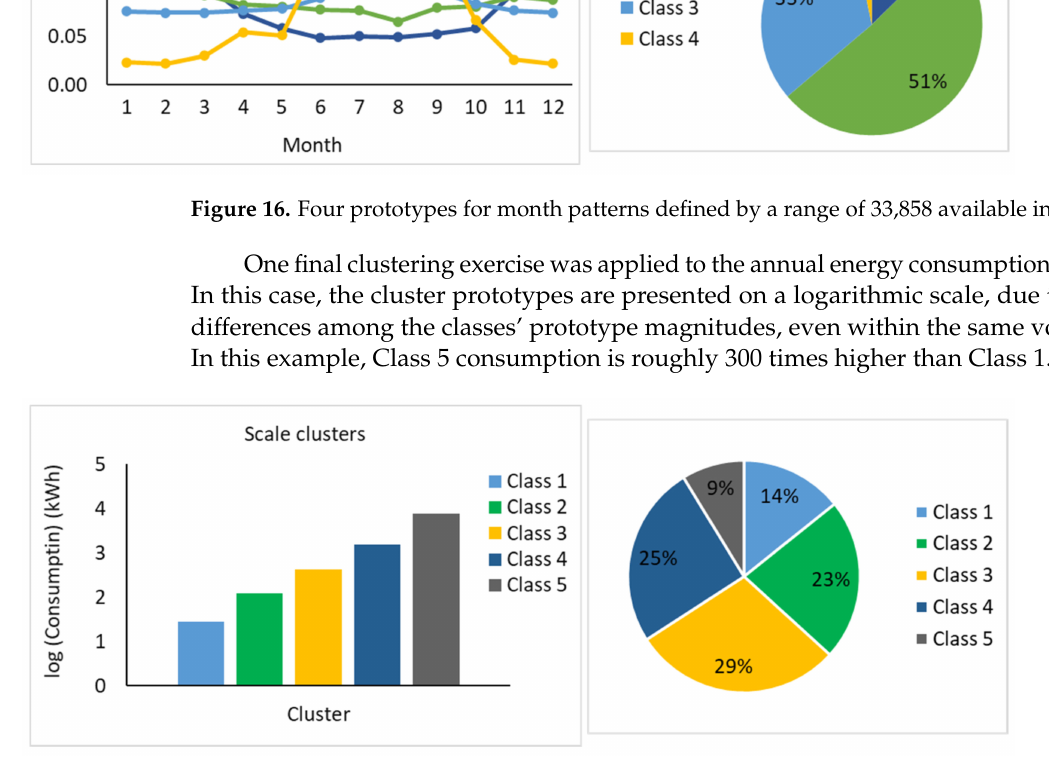
Figure 17. The scale classes for annual energy consumption defined by a range of 22,296 available MV